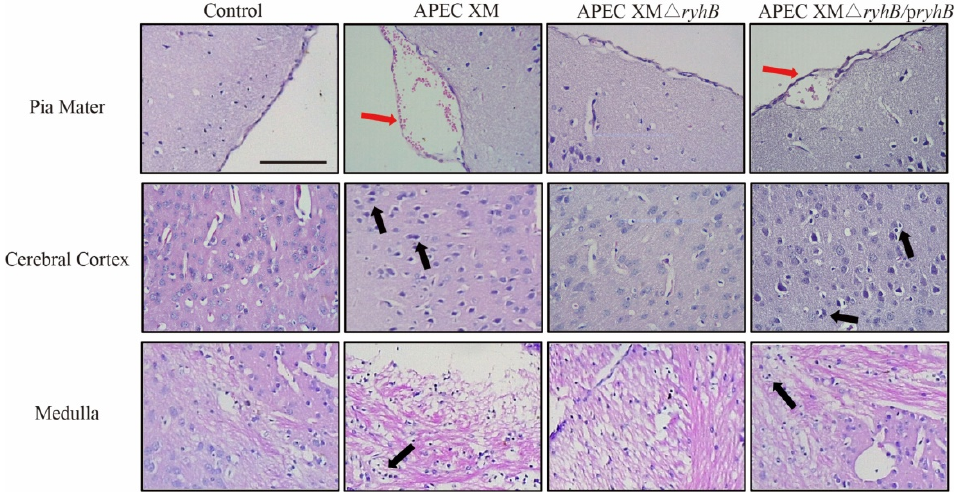
Figure 9. Histopathological analysis of the brain tissue of mice infected with APEC XM, APEC XM Δ ryhB and APEC XM Δ ryhB /p ryhB , and non-infected mice. Sections were stained with hematoxylin-eosin and visualized under optical microscopy (bar = 100 µm). The thickened pia mater with hemorrhage (red arrowheads) was observed in the brain section of mice infected with APEC XM and APEC XM Δ ryhB /p ryhB . Leukocyte infiltration (black arrowheads) was observed in the cerebral cortex of mice infected with APEC XM and APEC XM Δ ryhB /p ryhB .